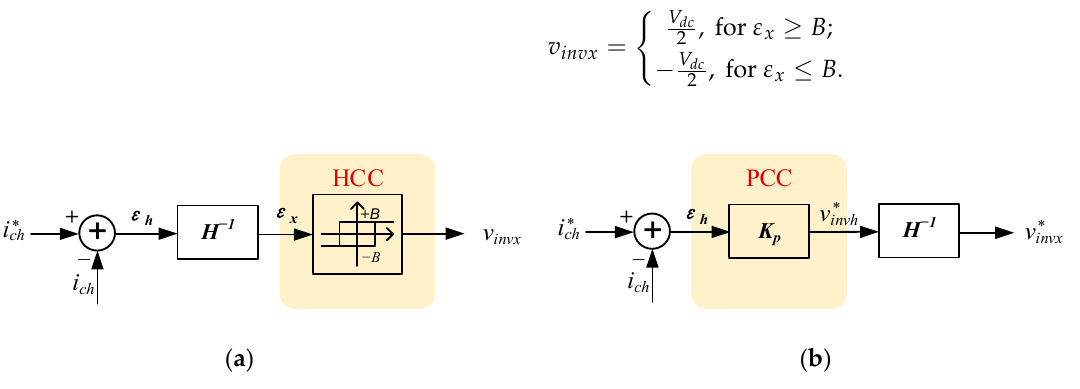
Figure 4. Control block diagram of ( a ) HCC; ( b ) PCC.